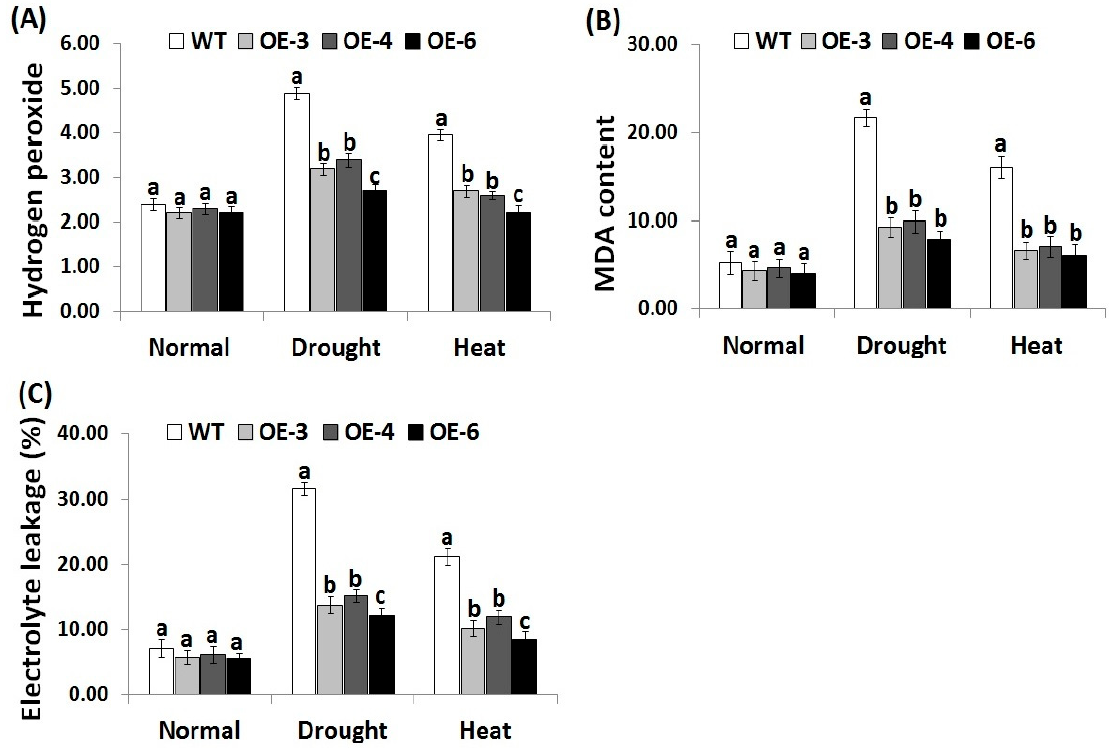
Figure 2. Hydrogen peroxide (H 2 O 2 , μ mol g − 1 FW) content ( A ), lipid peroxidation (malondialdehyde (MDA), μ mol g − 1 FW) level ( B ), and electrolyte leakage ( C ) of the wild ‐ type and transgenic rice plants